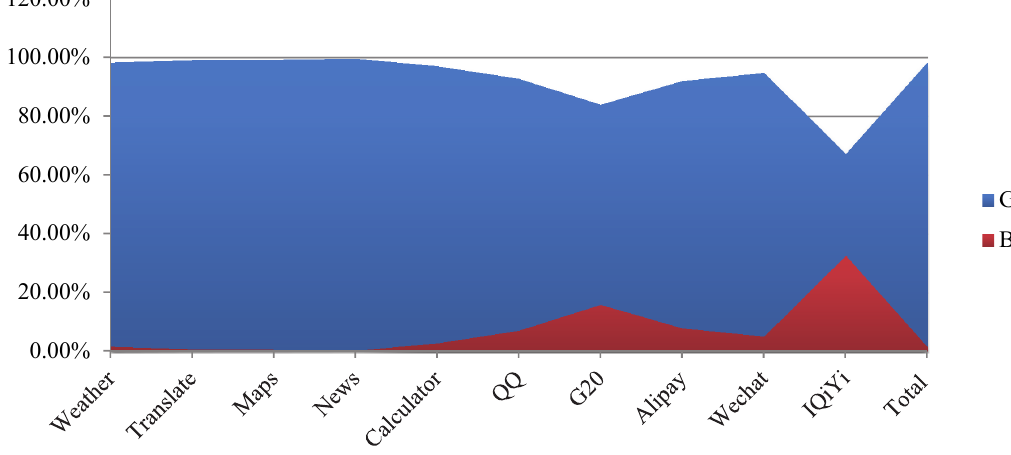
Fig. 6. Comparison of Relative Recall in SEs